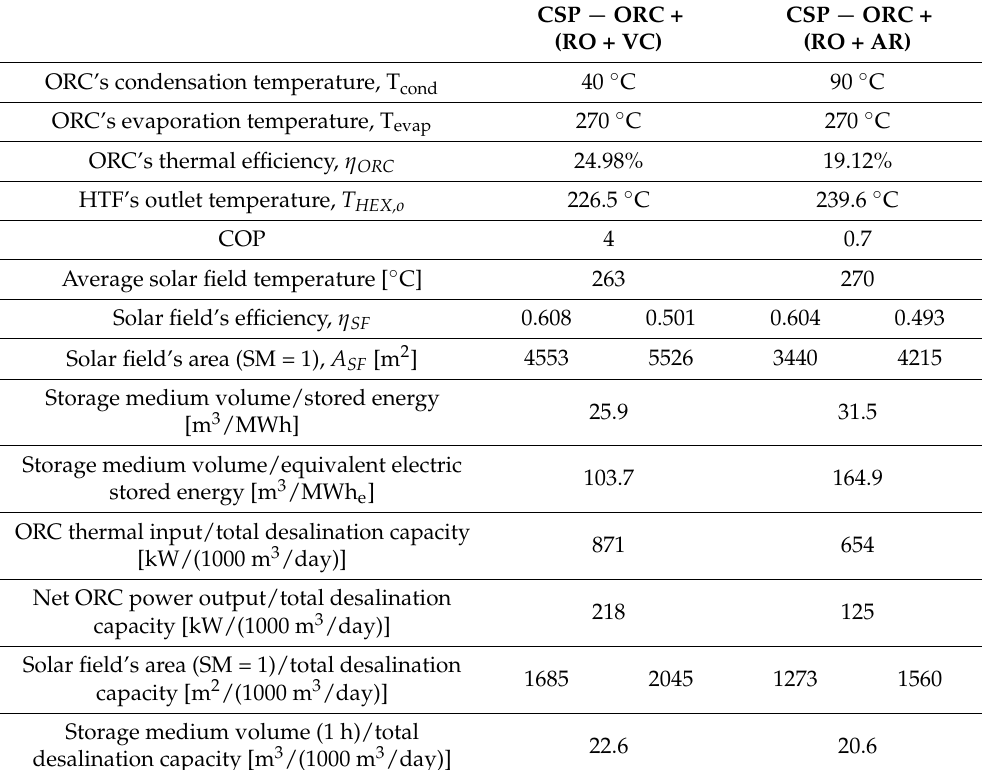
Table 5. Comparison of the CSP − ORC configuration for desalination and refrigeration (same desalination and cooling capacity). SEC RO = 3 kWh/m 3 ; direct TES with thermal oil Therminol